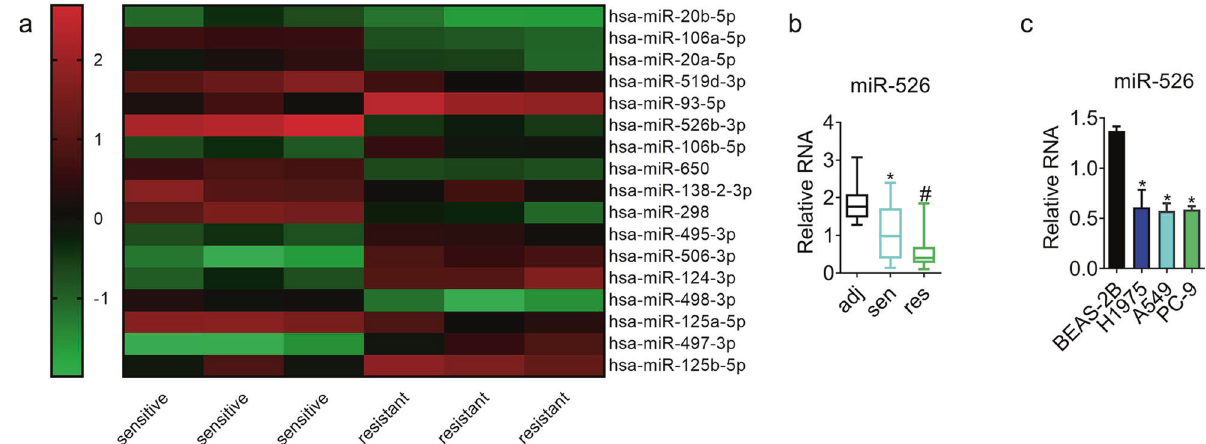
Fig. 1 miR-526b-3p declines in cisplatin-resistant lung cancer. a The differential expression of miRNAs between cisplatin-sensitive and cisplatin-resistant lung cancer is analyzed by miRNA microarray. The color indicates the fold change of the target gene normalized to the corresponding housekeeping genes. b , c miR-526b-3p expression in tumor specimens and cell lines is determined by qRT-PCR. adj adjacent tissues; sen cisplatin-sensitive tumor tissues; res cisplatin-resistance tumor tissues. *, P < 0.05 vs. adjacent tissues or BEAS-2B cells. #, P < 0.05 vs. cisplatin-sensitive